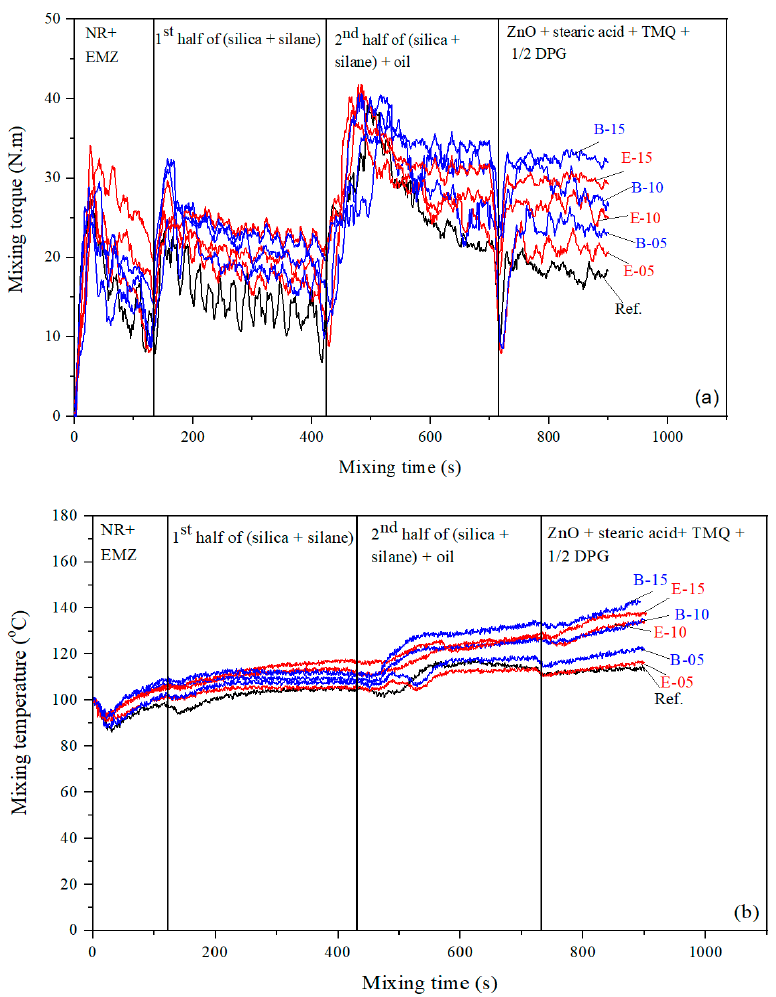
Figure 1. Mixing fingerprints based on ( a ) torque and ( b ) temperature of silica-filled NR compounds with various EMZ contents added via either extra addition (E05-E15) or blending